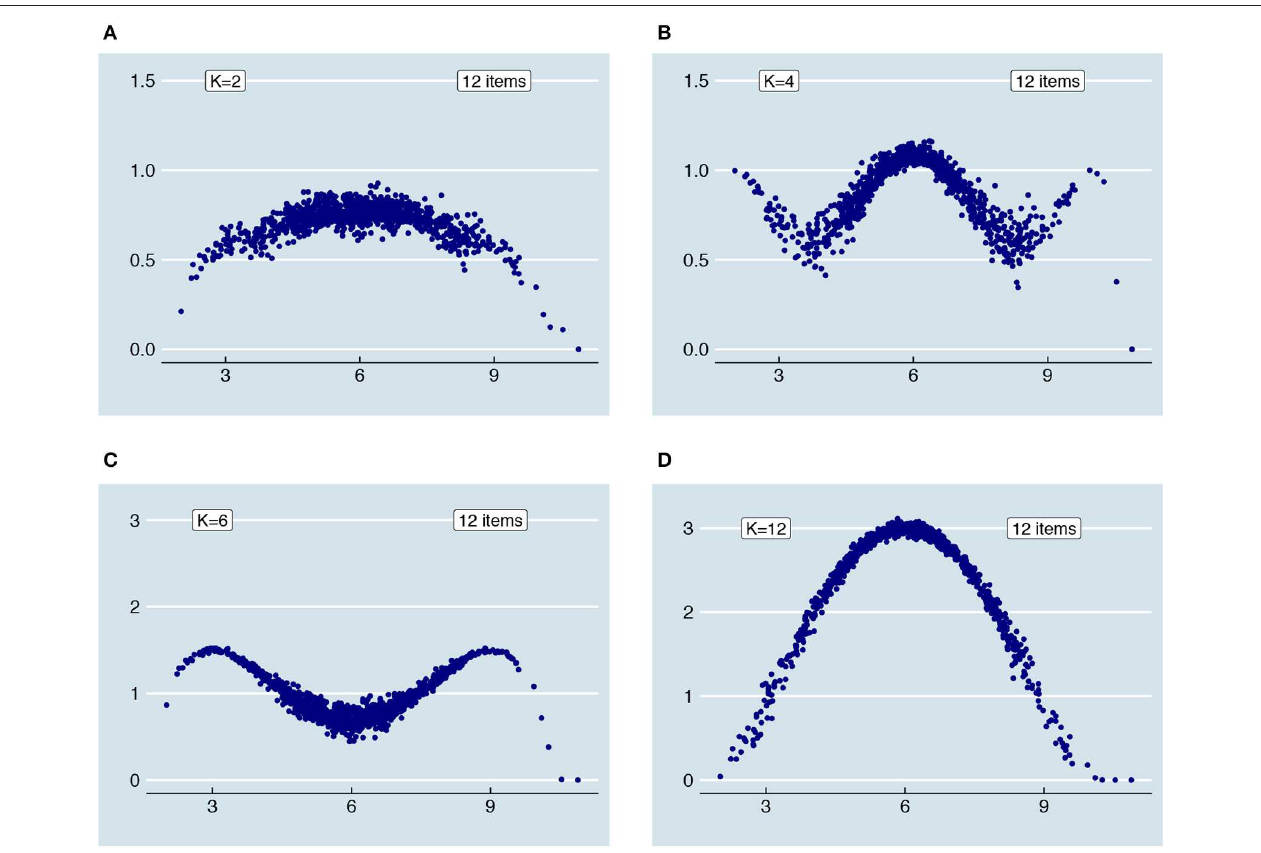
FIGURE 6 | Influence of rounding and truncation on error variances for a test with 12 items, a .8 reliability and K = 2, 4, 6, and 12 respectively. Note the difference in scale of (A) and (B) vs. (C) and (D)